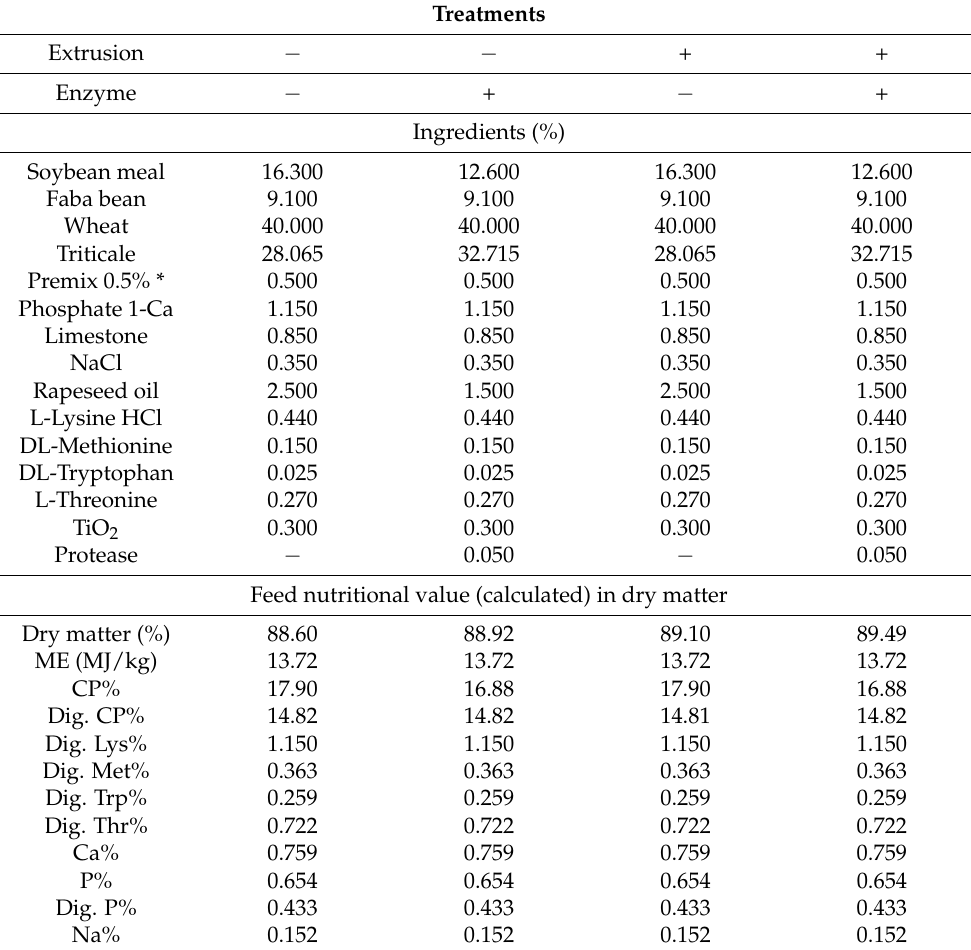
Table 2. The composition and content of nutrients in the experimental diets